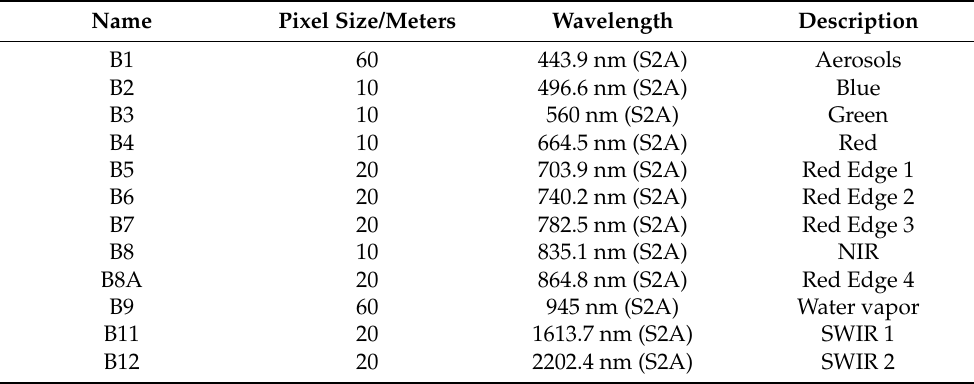
Table 2. Main parameters of the Sentinel-2 sensor.